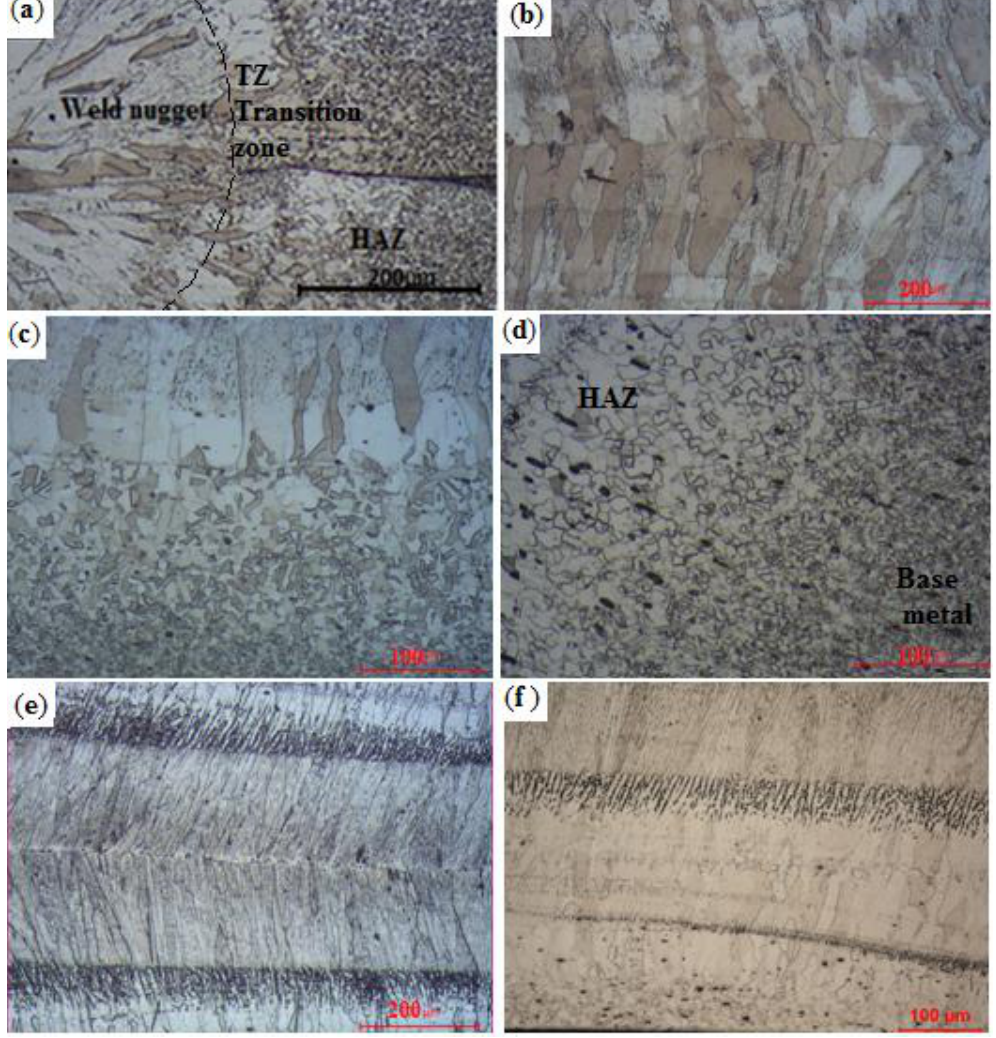
Figure 7. The microstructure of a spot-welded sample: ( a ) three distinct zones of weldment; ( b ) fusion zone; ( c ) transition microstructure from the weld nugget to HAZ; ( d ) microstructure from HAZ to base metal; and ( e , f ) columnar dendrites in the fusion zone.